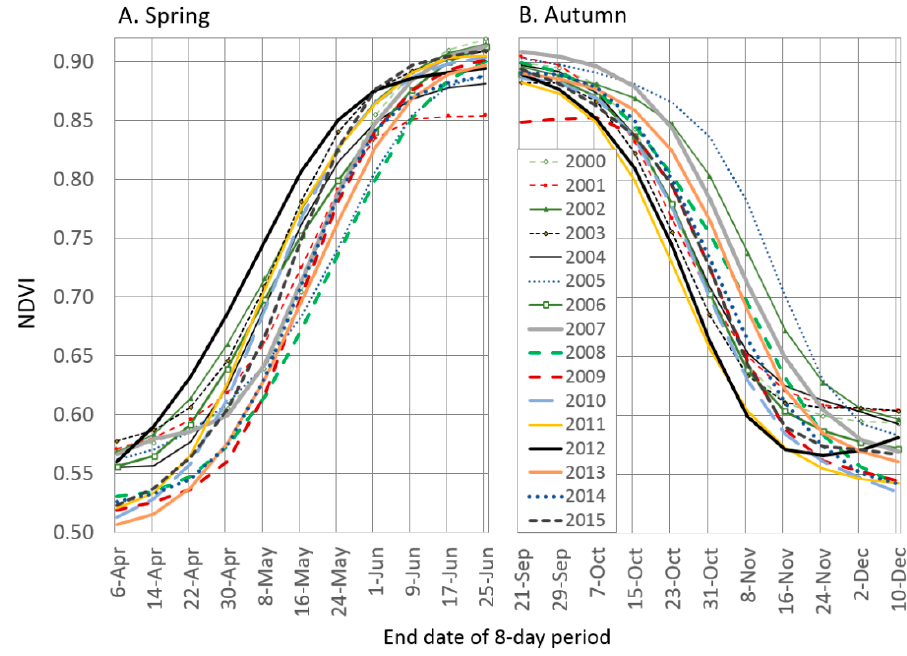
Figure 4. Mean variation in the timing and progression of spring and autumn, 2000–2015, for deciduous forests below 1515 m (5000 ft.) in Great Smoky Mountains National Park.